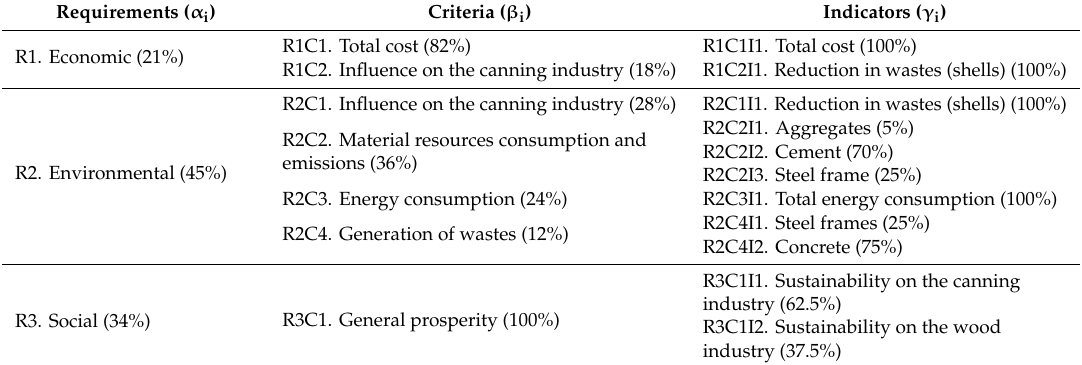
Table 8. Decision tree of the sustainability